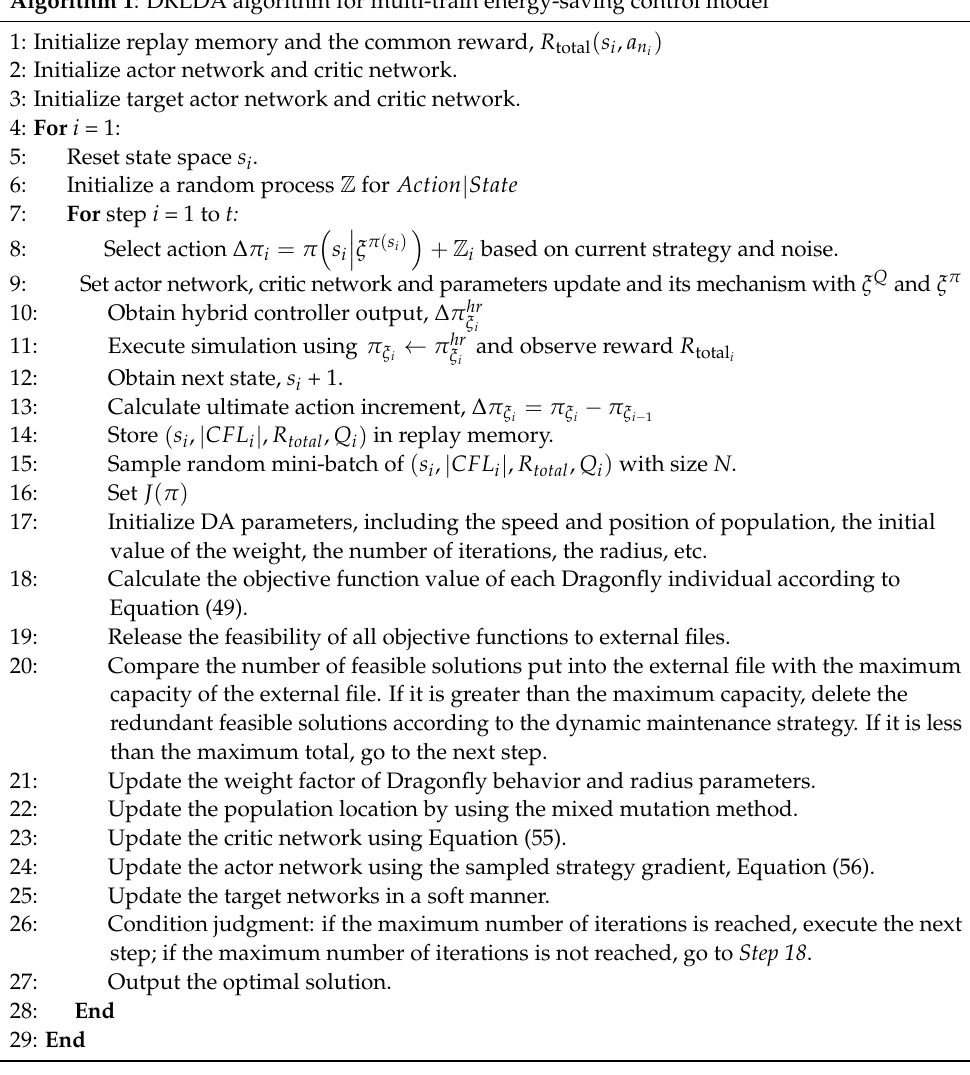
The Pseudo Code of DRLDA Algorithm (Algorithm 1) Algorithm 1 : DRLDA algorithm for multi-train energy-saving control